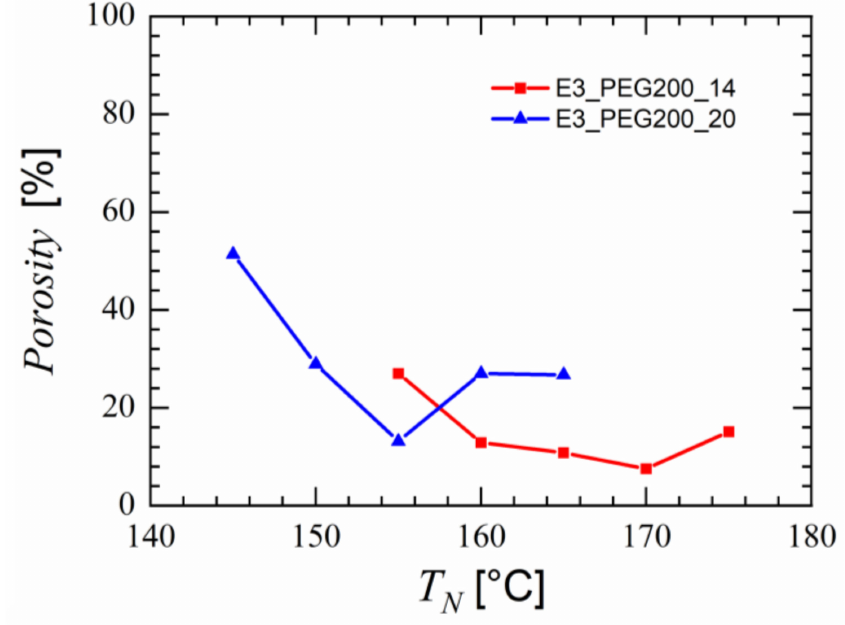
Figure 14. Porosities of foams obtained from the blends E3_PEG200_14 and E3_PEG200_20 at different nozzle temperatures during foam extrusion.